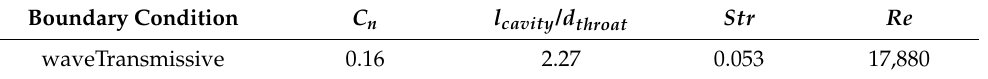
Table 6. Calculated values for 8.5 MPa MUSCL with wave transmissive and 12 mm length geometry. Boundary